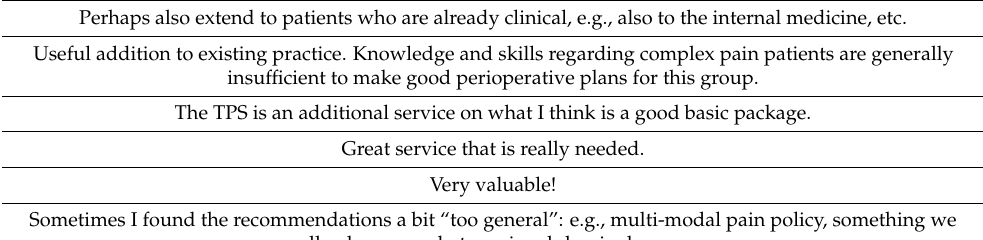
Figure 1. Bar charts answers of care providers satisfaction in the Transitional Pain Service survey. Satisfaction was measured using a Likert scale including a range of five response options from never (1 point) to always (5 points). Abbreviations: TPS = Transitional Pain Service. Table 1. Additional comments in free text survey, translated to English from Dutch.